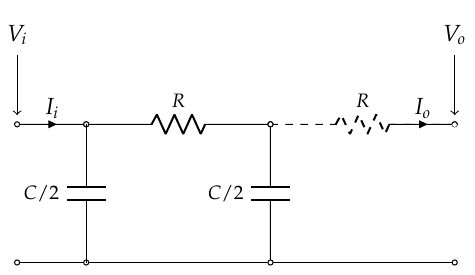
Figure 5. Electrical analogy for cables.